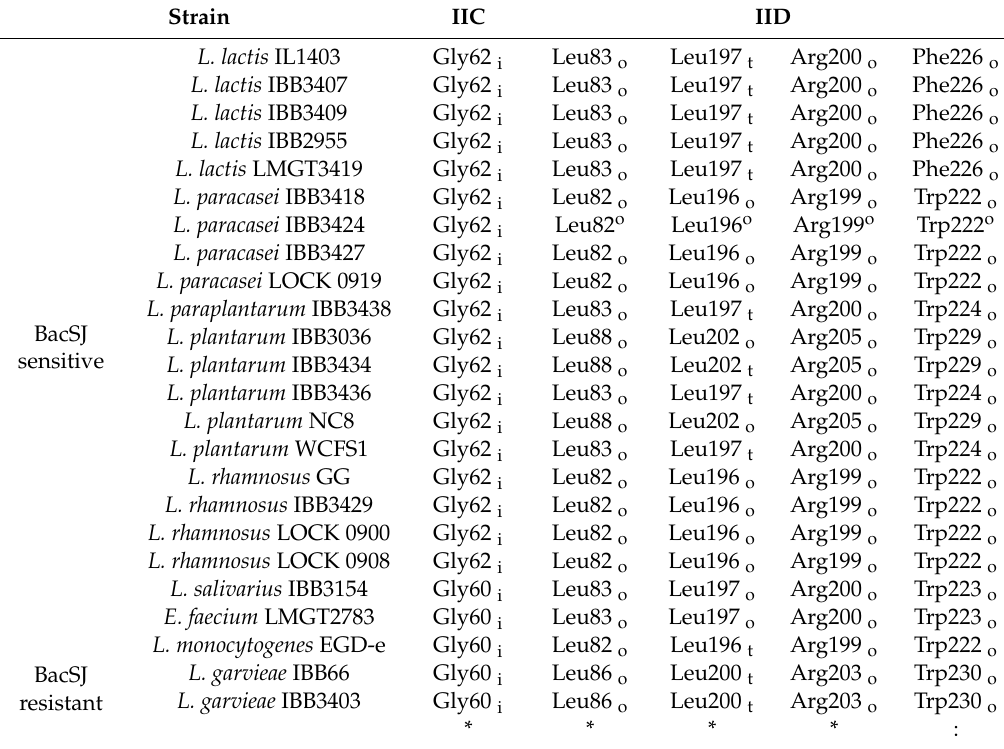
Table 3. Alignment of Man-PTS IICD amino acids substituted in L. lactis IL1403 mutants resistant to BacSJ with their counterparts in di ff erent